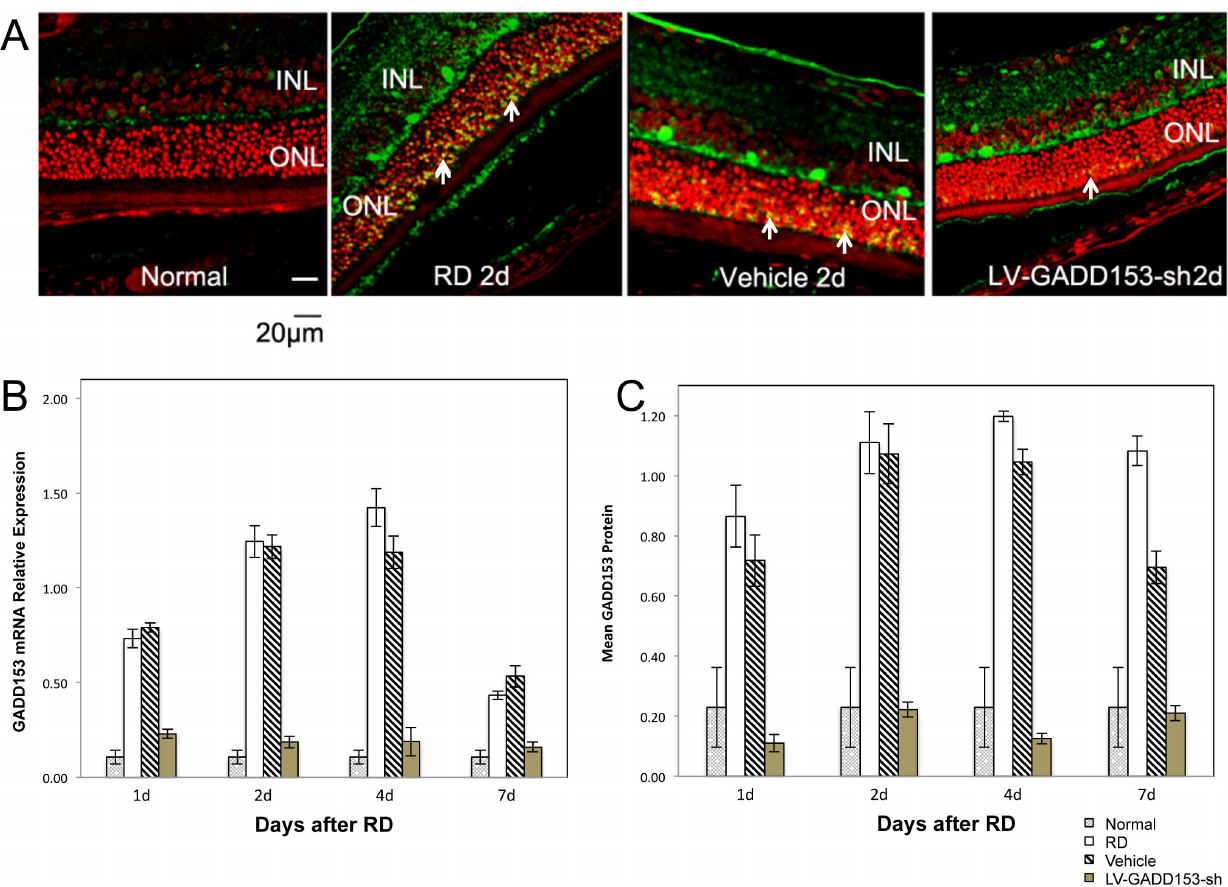
Figure 1. GADD153 RNA interference decreased GADD153 mRNA and protein contents in vivo. (A) Representative retinal sections from rats on 2 days after RD. Nuclei were counterstained with PI ( red ). GADD153 staining ( green ) is evident in ONL. Because of the digital overlay of PI and GADD153 staining in Figure 1, the location of the GADD153 staining should be in yellow color in the outer segments. The yellow color were observed in the ONL 2 days after detachment and disappeared under GADD153 RNAi. There were no GADD153-positive cells in retinas of the normal control group. GADD153-positive cells in ONL increased after retinal detachment, most GADD153-positive cells were located in the ONL layer (GADD153 distribution was shown with white arrows). Compared with retinal detachment group, GADD153-positive cells decreased in RNA interference group (LV-GADD153-sh) but not in Vehicle group. (B) RT-PCR semi- quantification of GADD153 mRNA expression in RD rats under shRNA, vehicle or non- treatment. GADD153 mRNA increased in RD groups with the highest expression found at 2 to 4 days after detachment and then decreased. The change of mRNA in vehicle group was the same as that in the non-treated RD group. The RNA interference group (LV-GADD153-sh) showed a very low level of GADD mRNA. (C) Signal intensities of GADD153 protein were measured by Bandscan analysis and the ratios of GADD153 protein expression to b -actin in each sample were given. West blotting revealed similar changes of protein expression at different time points after RD. The RNA interference group (LV-GADD153-sh) showed a very low level of GADD